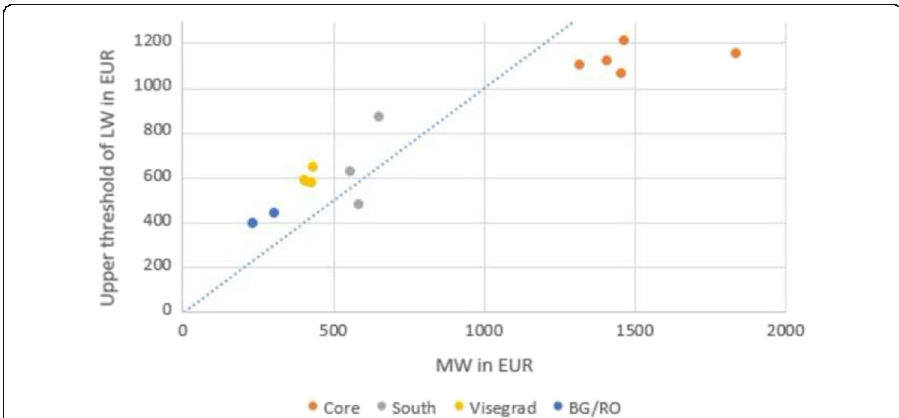
Fig. 2 Graphical distribution of countries based on individual MW and LW. Source: own calculation based on WI from December 2016. Q1 2017 Eurostat data used for MWs